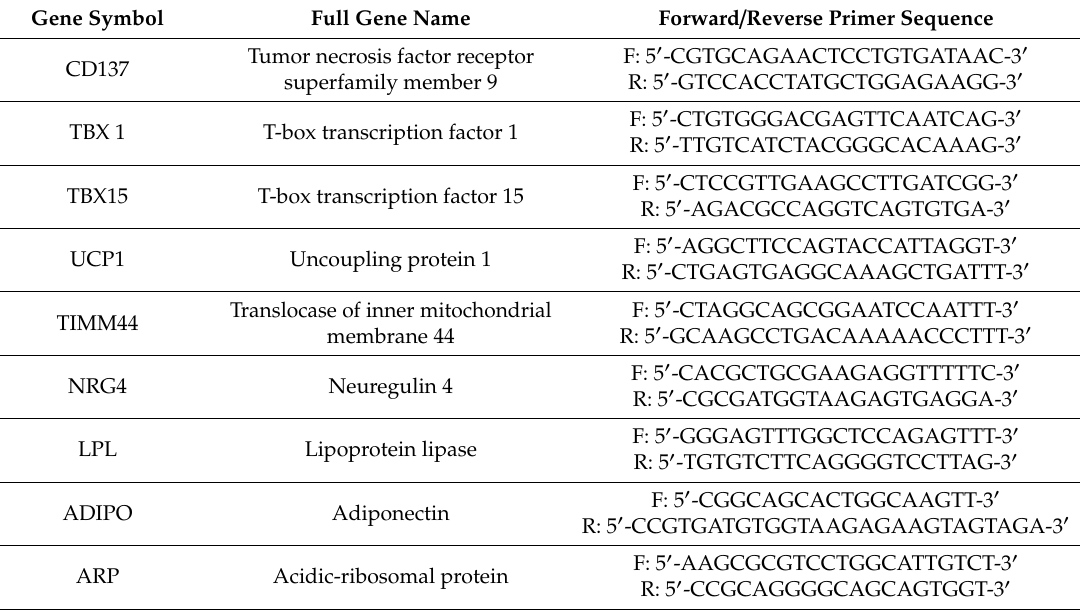
Table 1. Gene-specific primer sequences used for real-time-quantitative